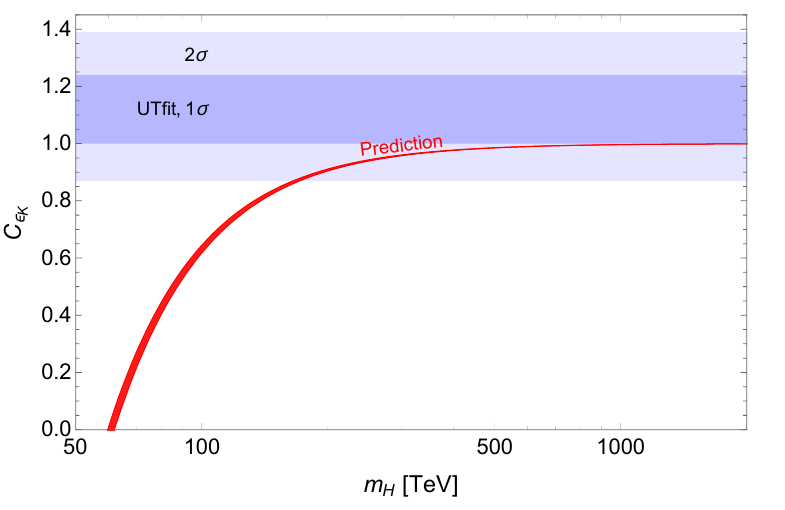
Figure 1 . The model prediction for C (cid:15) as a function of heavy Higgs mass m H is shown by red K band. The horizontal blue bands show the UTfit result within 1 σ (darker) and 2 σ (lighter) [82,